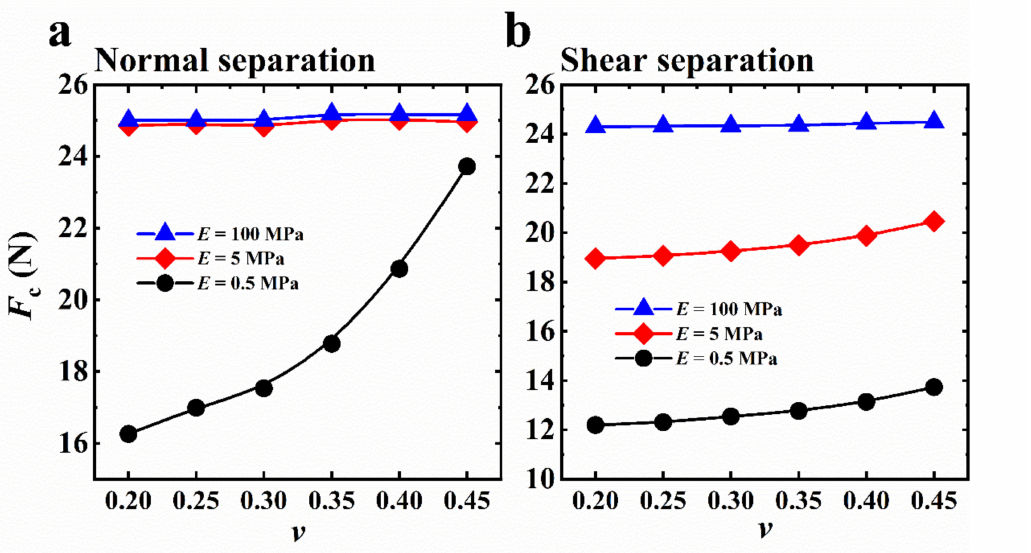
Figure 11. 3D FE simulation results for F c versus v .